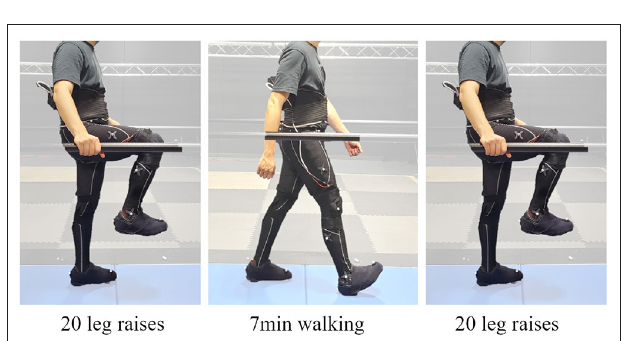
FIGURE 5 | Each trial consisted of 20 leg raises, followed by 7 min of walking at 1.23 m/s speed, and concluded with another 20 leg